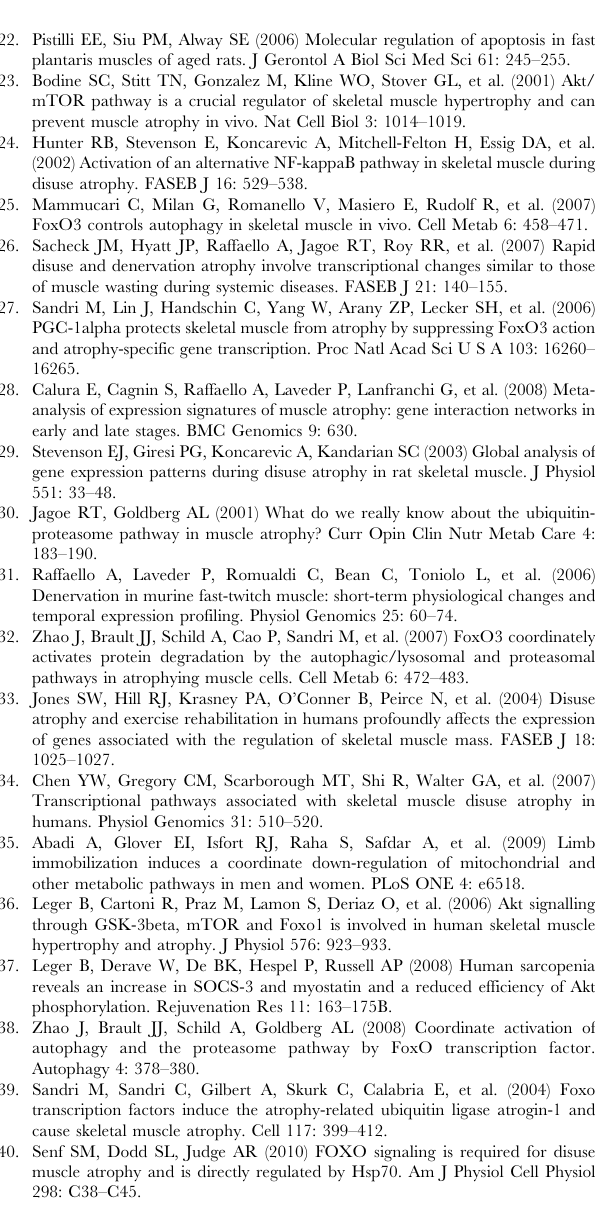
are geometric means 6 back-transformed SEM. Table S1 Subject characteristics. There was no difference between subjects from the 14 days and 4 days immobilization study with respect to age, weight and BMI, young and old respectively, however, old subjects weighed more and had a higher body mass index (BMI) than young subjects. # Age effect, p , 0.05 old compared to young within time point. Data are means 6 SEM. Table S2 Primers for the qRT-PCR and TaqMan Low Density array (LDA) assay ID. A. The mRNA expression of FoxO1, FoxO3, FoxO4, PGC-1 a , PGC-1 b , IL-6, MGF, IGF-1Ea and RPLP0 were analyzed by quantitative real-time RT-PCR.